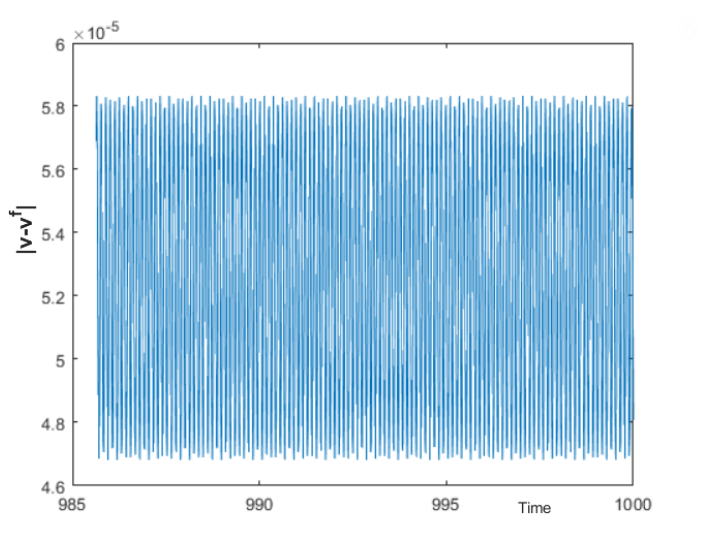
Figure 6. | v − v f | for a Reynold’s number of 10 4